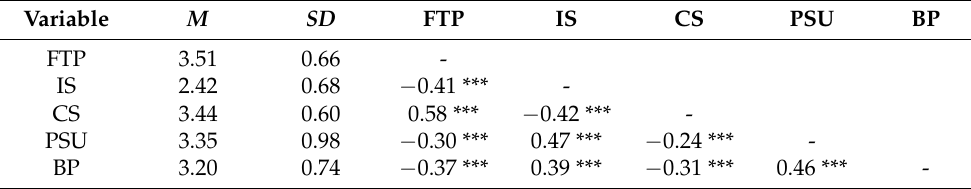
Table 1. Descriptive statistics and correlations among variables.